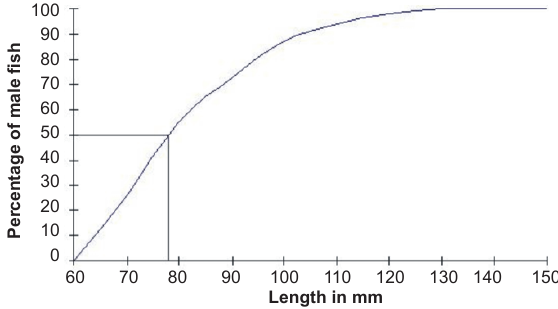
Figure 2. Relation of alimentary canal length with weight of fish